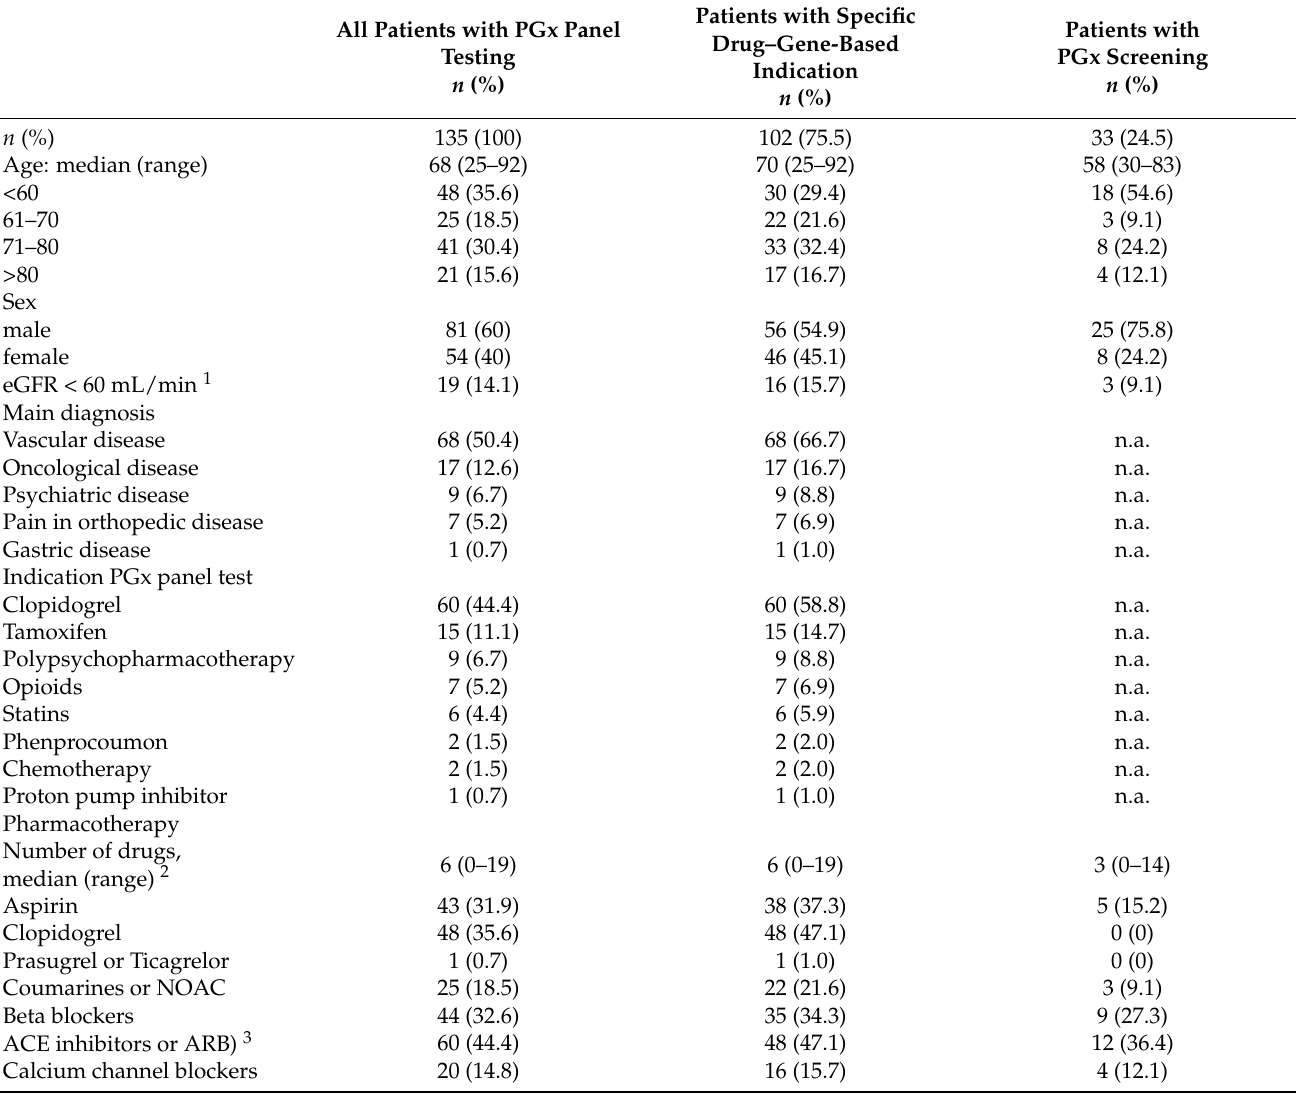
Table 1. Patient